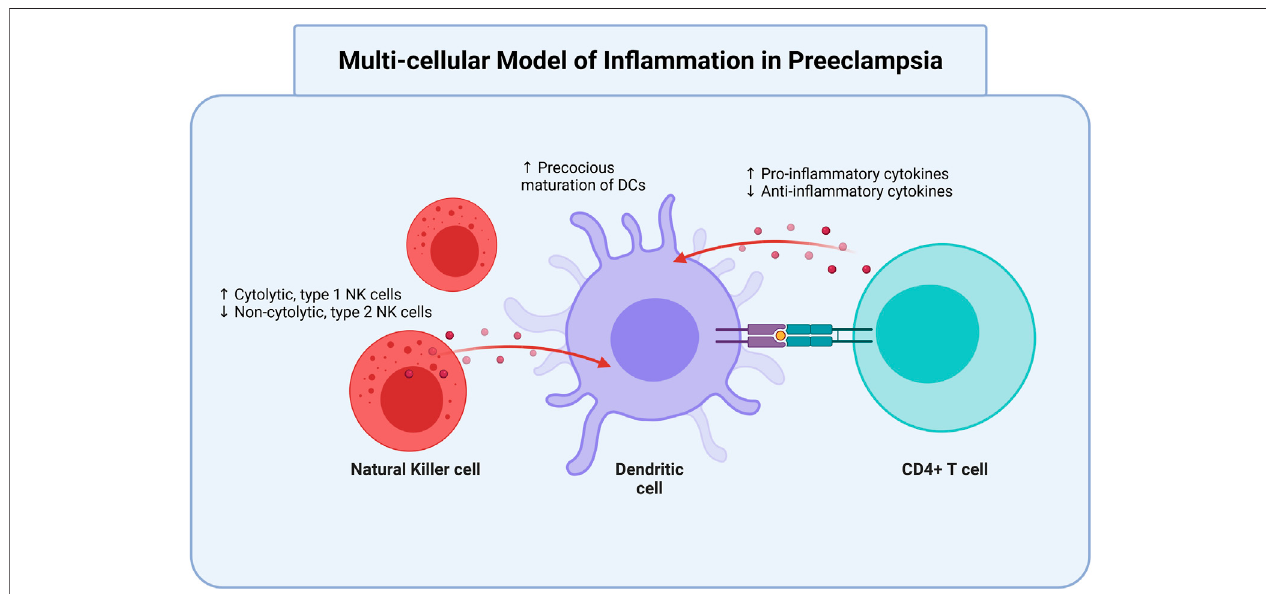
FIGURE 1 | Dendritic cells are modulated by T cells and NK cells in preeclampsia. Oxidative and vascular stress contribute to preeclamptic conditions. In preeclampsia,thereisanincreaseofcytolytic,type1NKcellsandprecociousmaturationofDCs,aswellasincreasedproductionofpro-in fl ammatorycytokines.Thereis a simultaneous decrease in non-cytolytic, type 2 NK cells and anti-in fl ammatory cytokines. All three cell types interact to aggravatethe elevated pro-in fl ammatory status that contributes to and occurs in preeclampsia. NK, natural killer; DC, dendritic cells. Created with https://biorender.com.